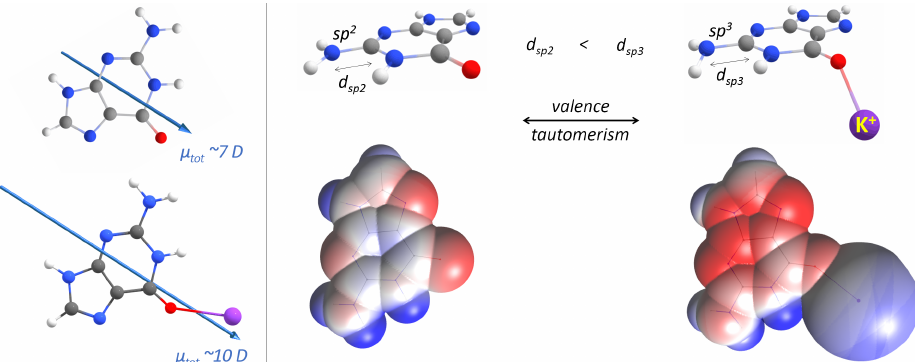
Figure 8. Left : The dipole moments calculated for guanine alone ( top ) and upon coordination of a metal cation ( bottom ) at the QM level of theory. Right : The valence tautomerism observed in guanine upon the coordination of a metal (here, potassium) cation. The intramolecular charge transfer that corresponds to the sp 2 to sp 3 transition of the amino group ( top ). The length of the C–N bond in the amino group was calculated as 1.362 and 1.371 Å for sp 2 and sp 3 hybridizations, respectively. The electrostatic potentials mapped on the van der Waals surfaces ( bottom ). Red and blue colours correspond to negative and positive charges, respectively. Note the increase in the negative charge (more red region) on the nitrogen in the amino group upon coordination of the cation, which corresponds to the sp 3